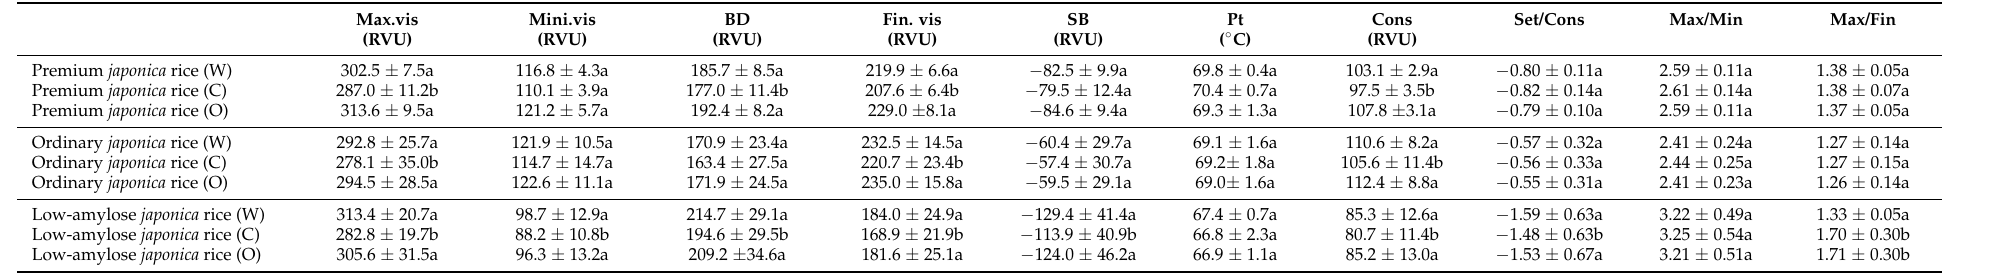
Table 1. Comparison between the pasting properties of chalky, whole, and original rice in 54 Japonica unpolished rice in